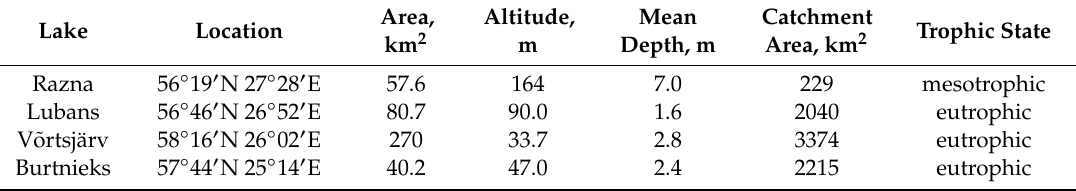
Figure 1. The locations of the study lakes. Table 1. Characteristics of the lakes under